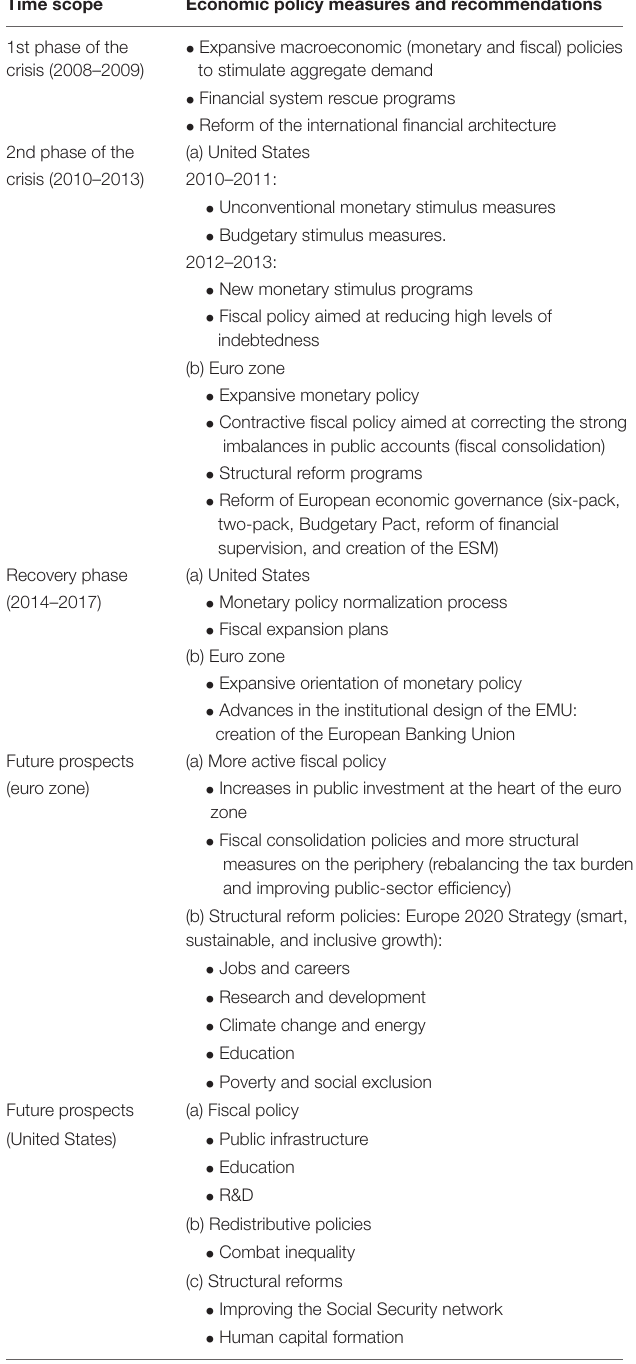
TABLE 7 | Economic policy measures to combat secular